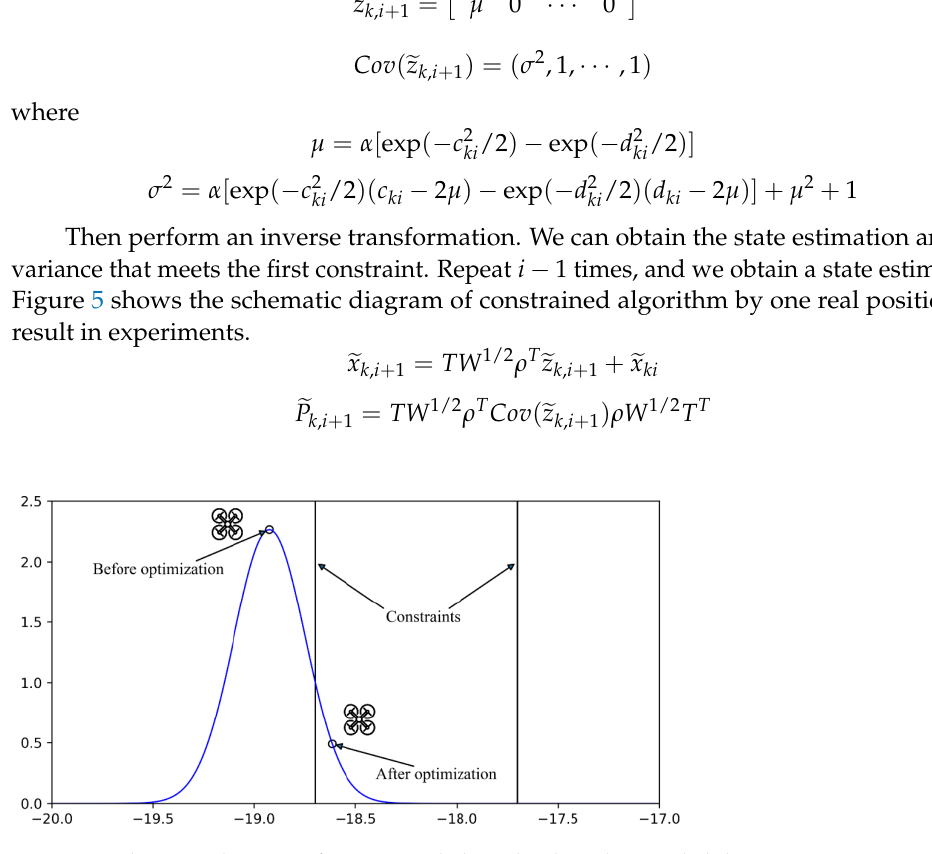
Figure 5. Schematic diagram of constrained algorithm based on